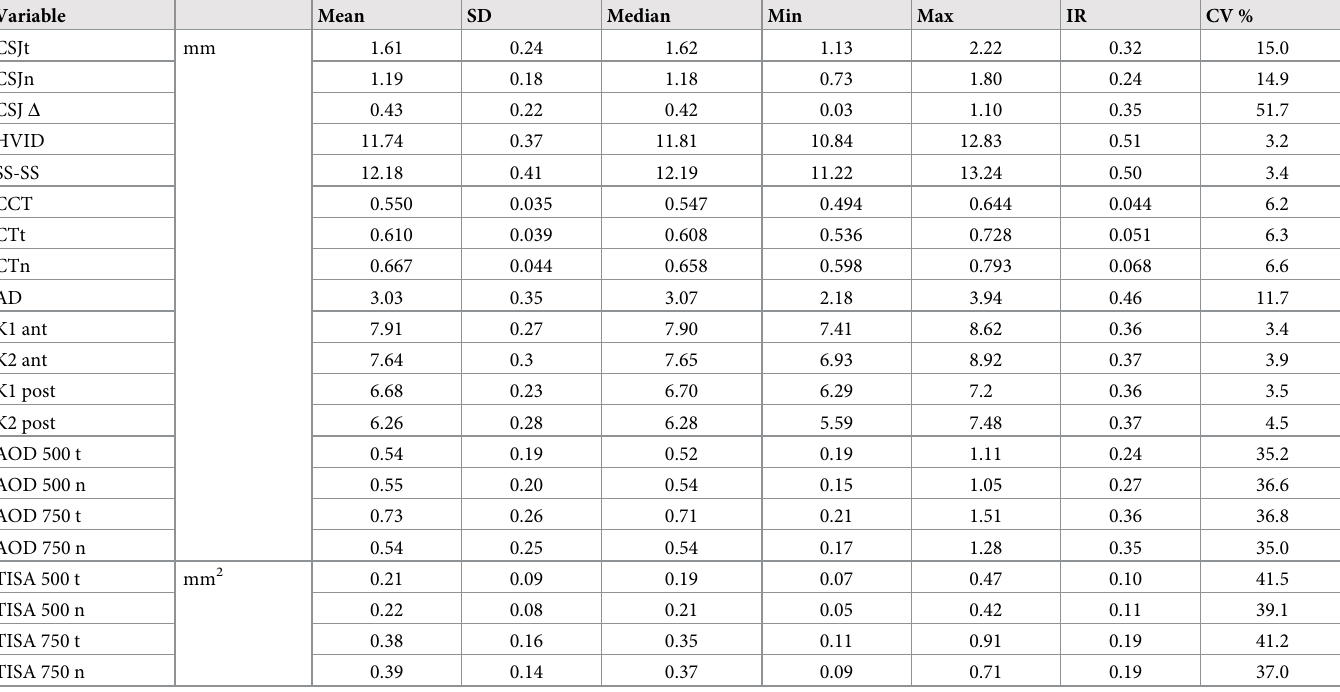
Table 1. Descriptive statistics of analysed ocular anterior segment variables: Mean, standard deviation (SD), median, minimum (Min), maximum (Max), interquar- tile range (IR) and coefficient of variation (CV). Variable